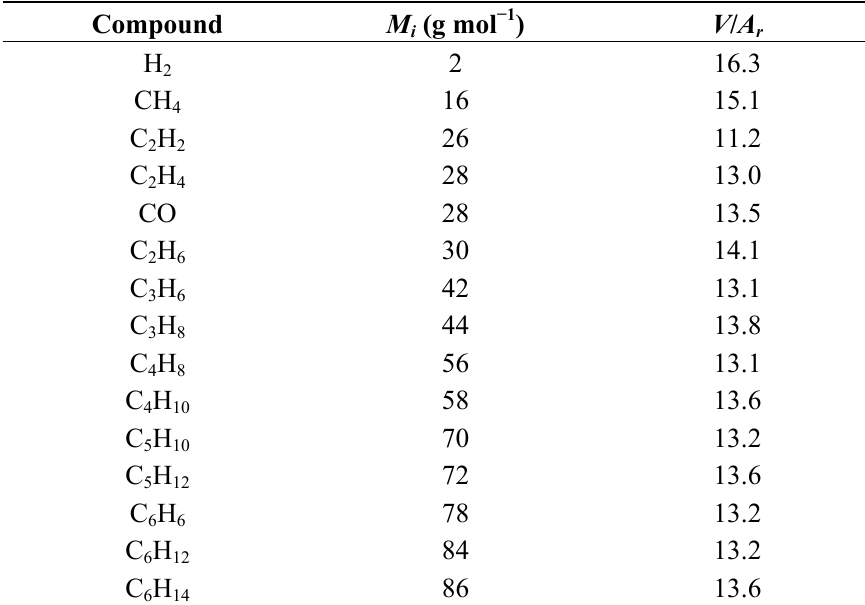
Table 4. Values of the parameter η (m) calculated for different positively/neutral buoyant gases and dense